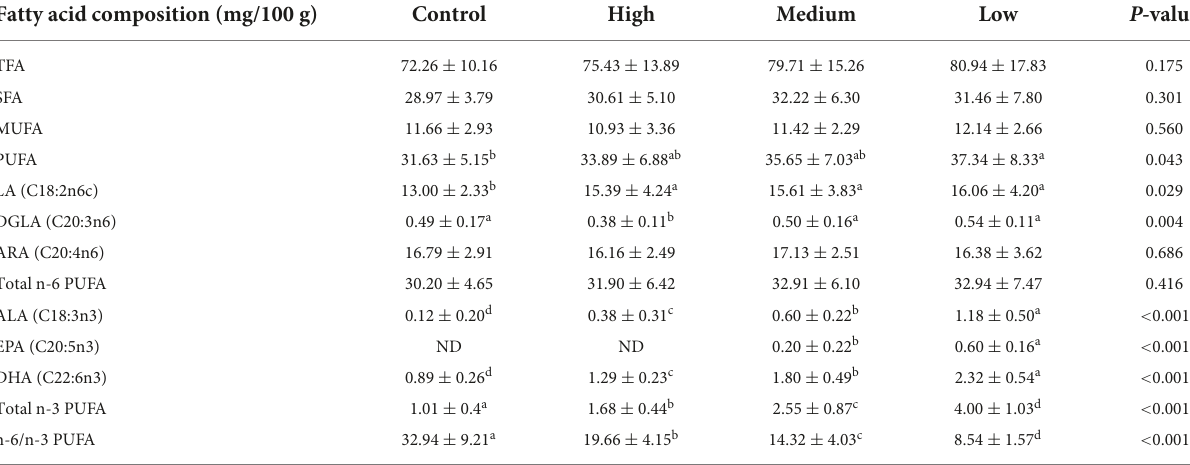
TABLE 6 Effects of different dietary linseed oil levels on the polyunsaturated fatty acid (PUFA) profile of duck breast muscle. Fatty acid composition (mg/100 g) Control High Medium Low P- value